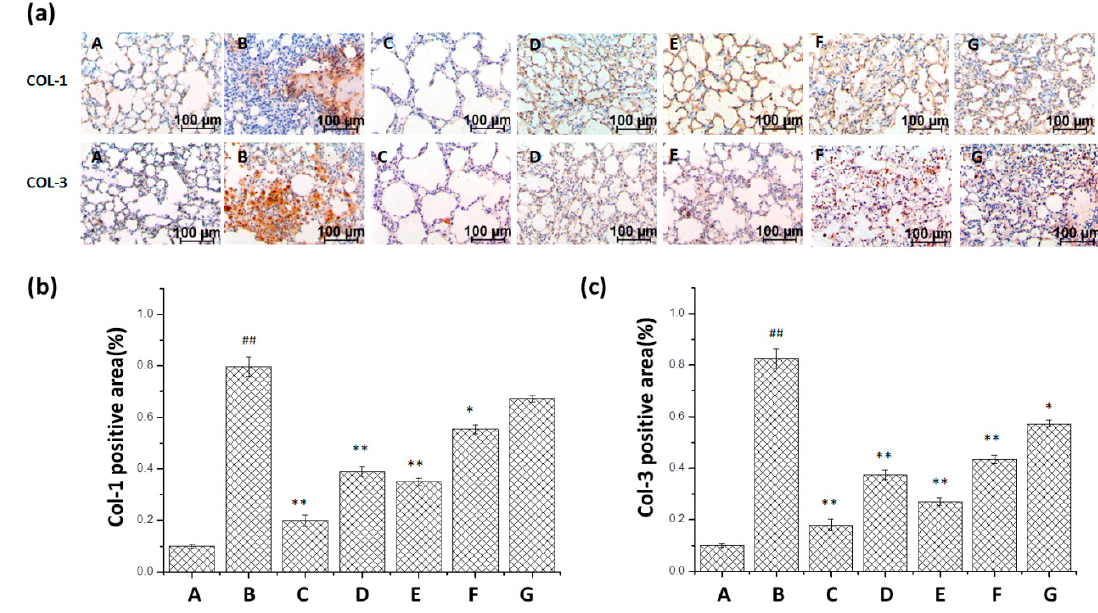
Figure 5. Effect of m KG on the mRNA Expression of Col-1, Col-3 in the lung tissues of BLM-induced pulmonary fibrosis mice by immunohistochemical analysis. ( a ) The Col-1, Col-3 expressions in the lung tissues were detected by immunohistochemical analysis (Col-1: upper panels; Col-3: lower panels). (Magnification, 200×); ( b ) The quantitative result of Col-1 expression; ( c ) The quantitative result of Col-3 expression. Data were expressed as mean ± S.D. ## p < 0.01 compared with the control group. * p < 0.05, ** p < 0.01 compared with the BLM group. (A) Normal group; (B) BLM group; (C) Pirfenidone group; (D) Dexamethasone group; (E) m KG-H group; (F) m KG-M group; (G) m KG-L group.